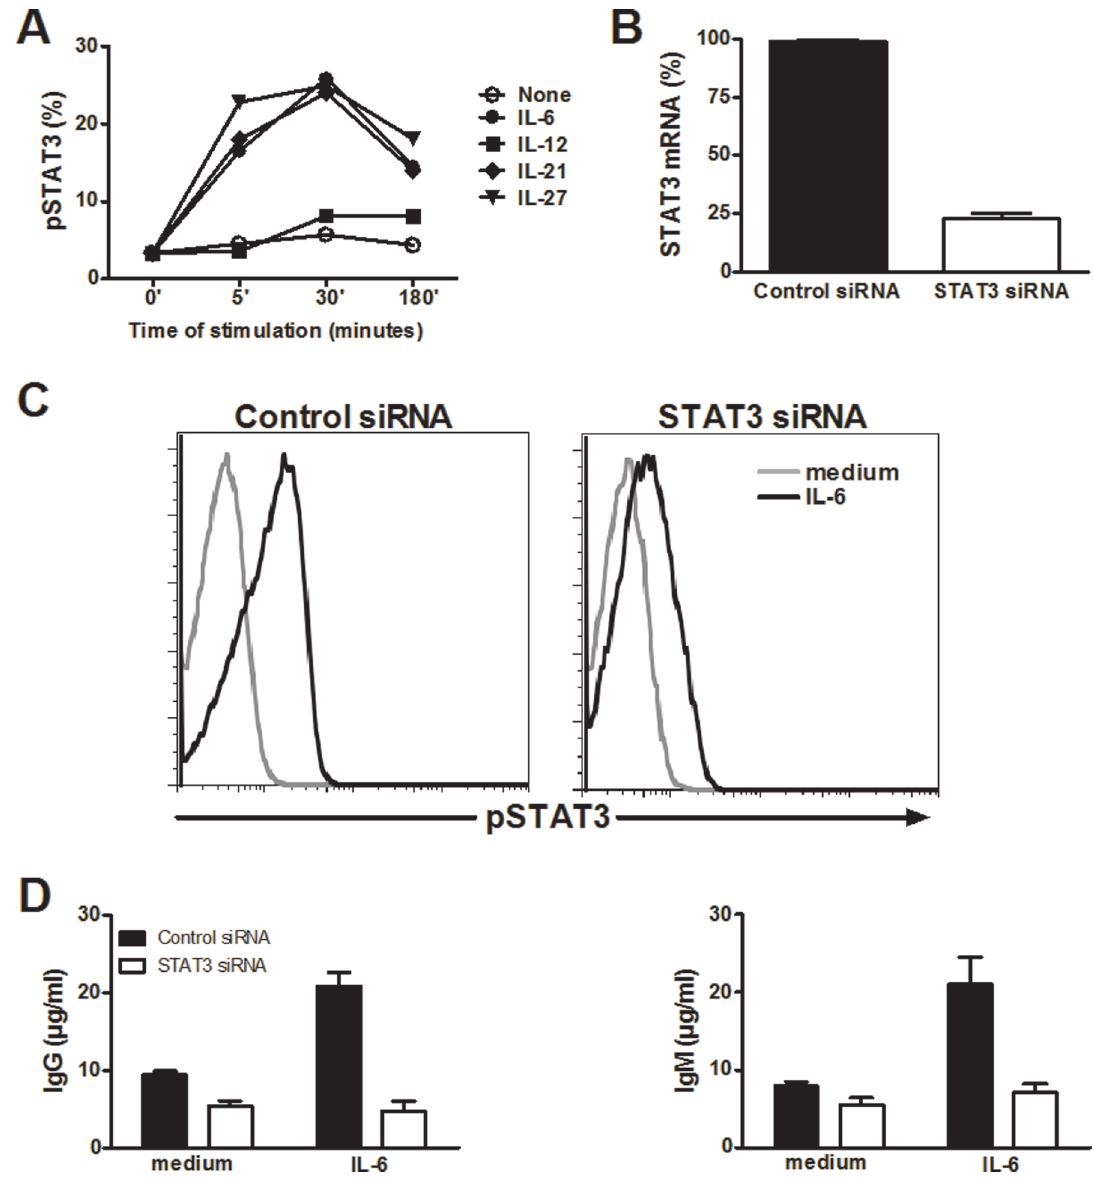
Figure 2. STAT3 is critical for the differentiation of CD4 T cells helping B cells induced by IL-6. A) Naive cord blood CD4 T cells were stimulated with the indicated cytokines before measuring phospho (p)STAT3 expression by flow cytometry. B and C) Naive cord blood CD4 T cells were incubated with STAT3 specific or control siRNAs in the presence of IL-2 for 48 hours. Transfected cells were stimulated for an additional 48 hours with plate-bound anti-CD3 (5 m g/ml) and soluble anti-CD28 (1 m g/ml) mAbs in the presence of rIL-6 or medium alone. We then assessed the expression of STAT3 mRNA by qRT-PCR and of pSTAT3 by flow cytometry. D) CD4 T cells were incubated in the presence of heterologous B cells before measuring the production of Ig as in Fig. 1. Data are individual results or mean 6 SEM of one representative of two experiments on different donors.